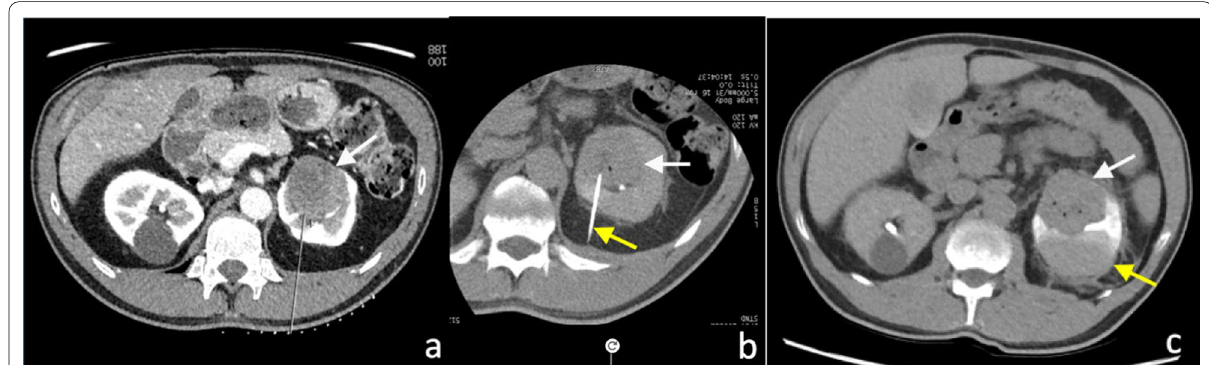
Fig. 8 a Axial CT image pre-biopsy planning image of percutaneous posterior approach of a left renal cell carcinoma (white arrow) and ( b ) image demonstrating a coaxial biopsy needle system (yellow arrow) within the left renal cell carcinoma (white arrow). c Subcapsular haematoma (yellow arrow) post-percutaneous biopsy of the left anterior renal cell carcinoma (white arrow). The 18-gauge core biopsies confirmed the diagnosis of mucinous tubular and spindle cell renal cell